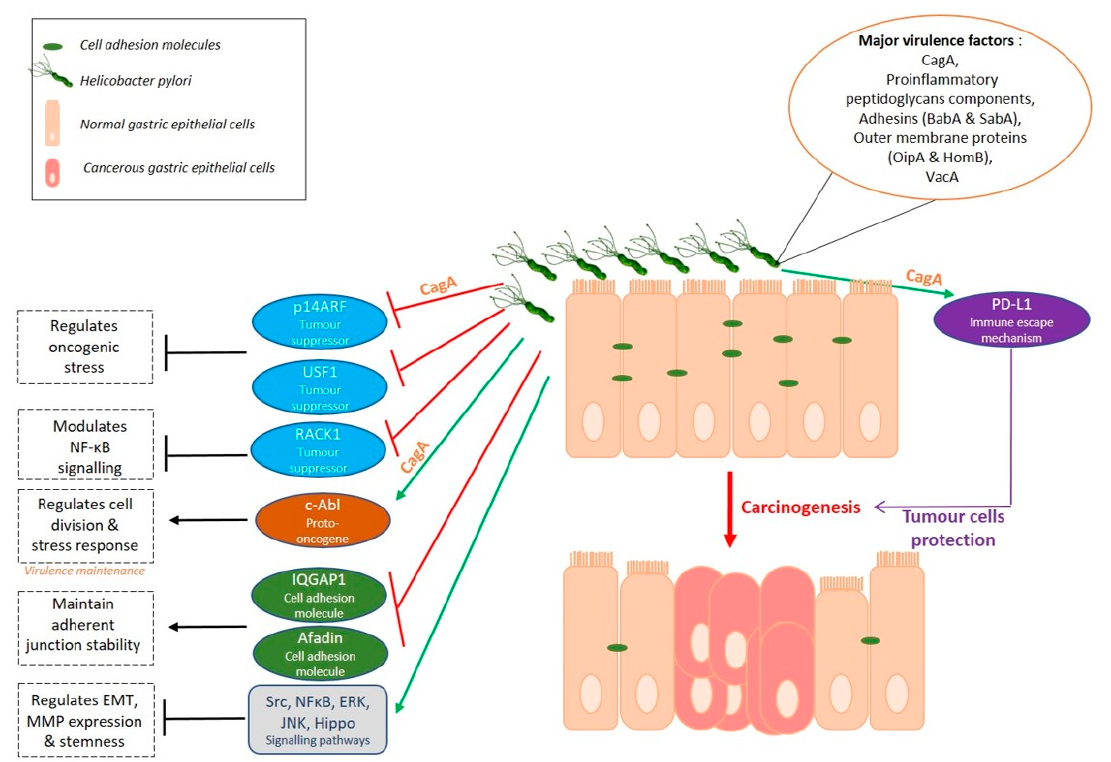
Figure 2. Gastric carcinogenesis: a Helicobacter disease.